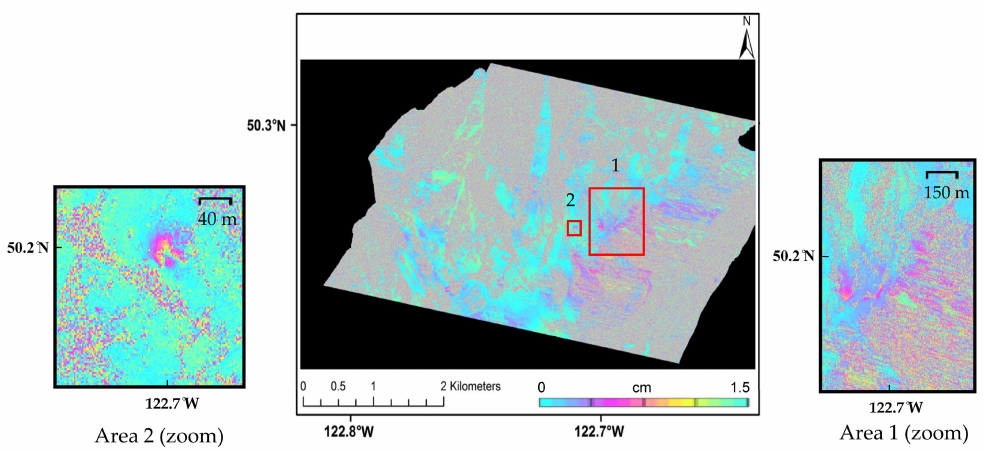
Figure 11. Mount Currie: Geocoded TSX interferogram (2 July 2017–6 September 2017). The two areas where deformation is observed are highlighted in red, and the zoom insets and the scales are also